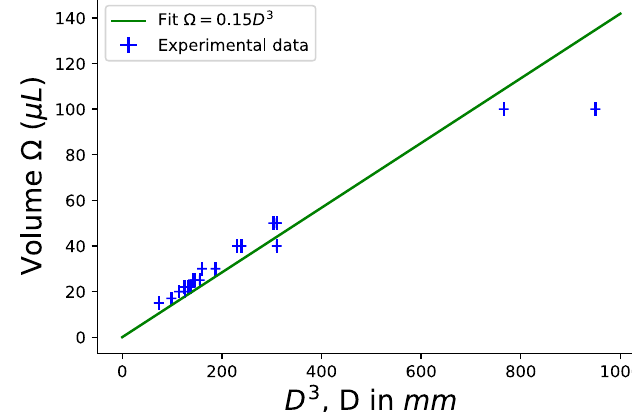
Fig. 7. Experimental law between the volume V and the diameter D of a drop de fi ned as the diameter seen from above the drop as it is lying on a horizontal fl oor. V ∝ D 3 is a consistent model for small enough drops. Fit does not take into account the two last points, where drops are so big that they spread under their own